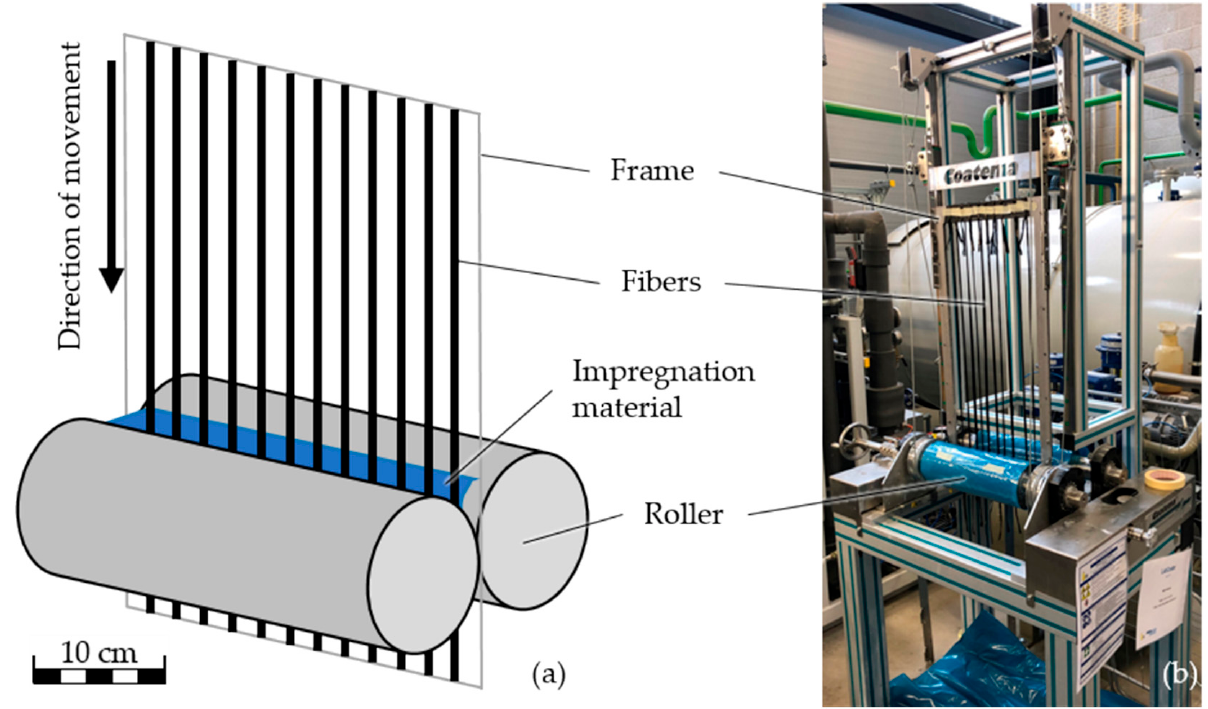
Figure 1. Representation of the discontinuous impregnation method used in this work: ( a ) schematic representation; ( b ) picture.